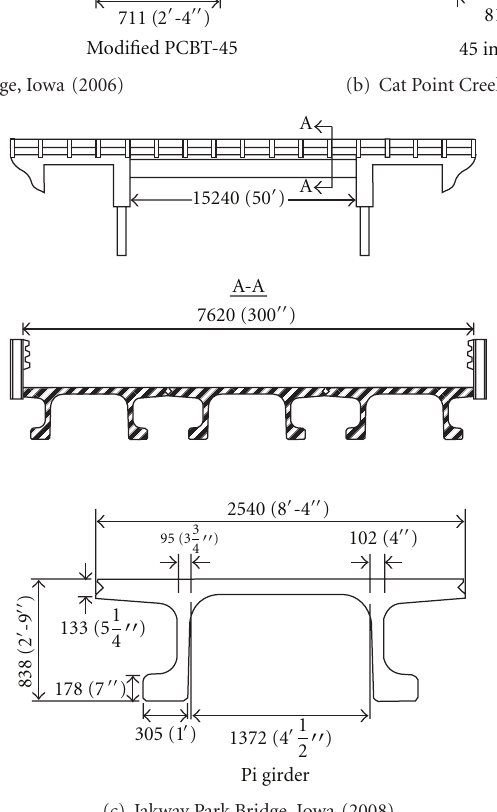
Figure 3: Early UHPC bridge applications in the US (in mm